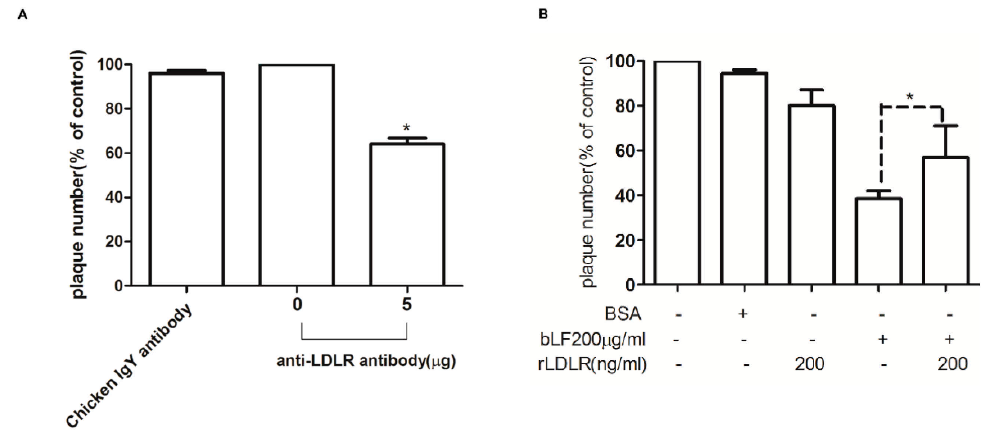
Figure 4. The role of low-density lipoprotein receptors (LDLR) in bLF inhibition of DENV-2 infection. Vero cells were incubated with anti-LDLR antibody, then infected with 200 PFU of DENV-2. ( A ) Vero cells were treated with bLF and recombinant LDLR alone or together; then infected with 200 PFU of DENV-2; ( B ), and analyzed in a plaque reduction assay (* p < 0.05).